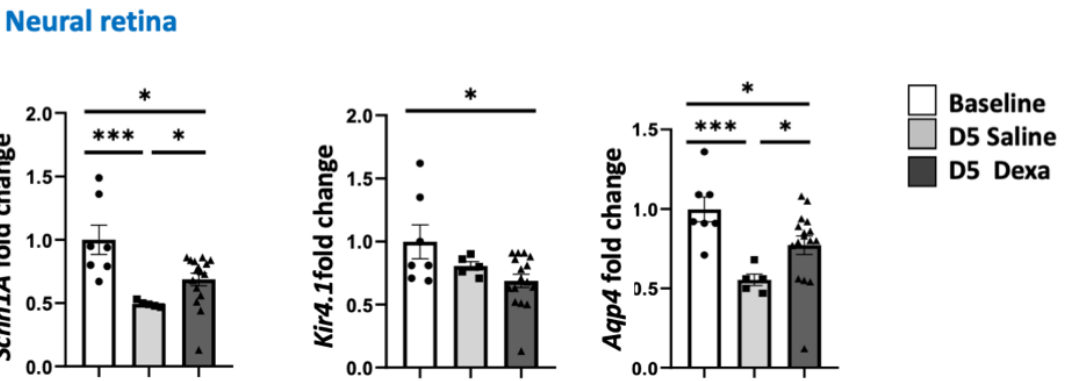
Figure 4. Regulation of MR-induced genes in the neural retina. Scnn1A encoding ENac- α Kir4.1 and Aqp4 expression at baseline ( n = 7), after 5 days of daily injection of dexamethasone ( n = 16), or saline ( n = 6), * p < 0.05, ** p < 0.01, *** p < 0.001.